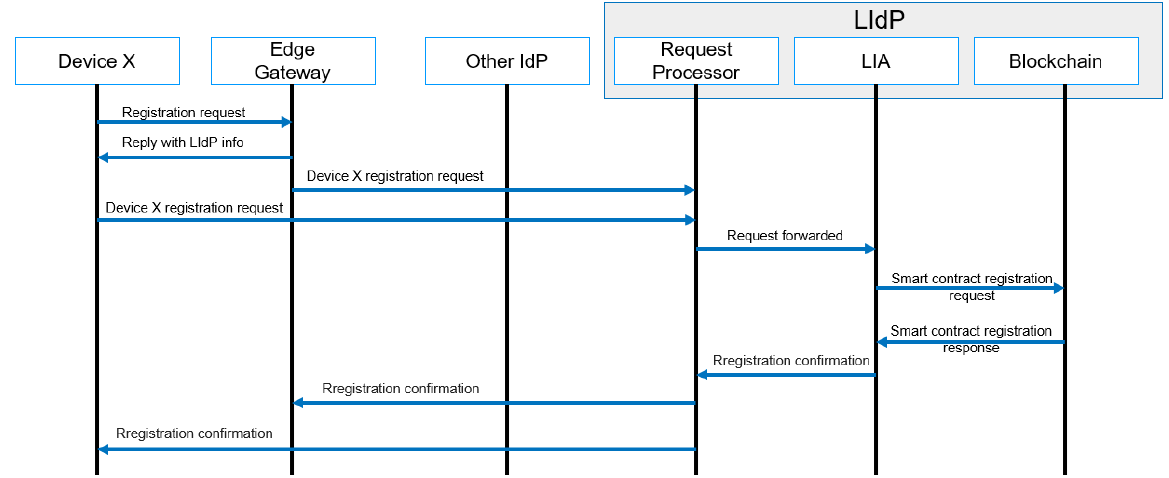
Figure 8. Registration process message flow. 4.4.2. Authentication Any user, user device, or IoT device needs to be authenticated before performing any task within the IoT infrastructure. Here, a task can be defined as data transfer, data store, and data access to any other device connected to the specific network. A simplified mes- sage flow model for authentication is shown in Figure 9. The same figure applies for both authentication and authorization. The authentication varies based on the type of device. Based on use cases, the IoT devices need to store and transfer data with the nearest edge IoT gateways. The authentications of IoTDs are automated via the EIoTG. Every packet